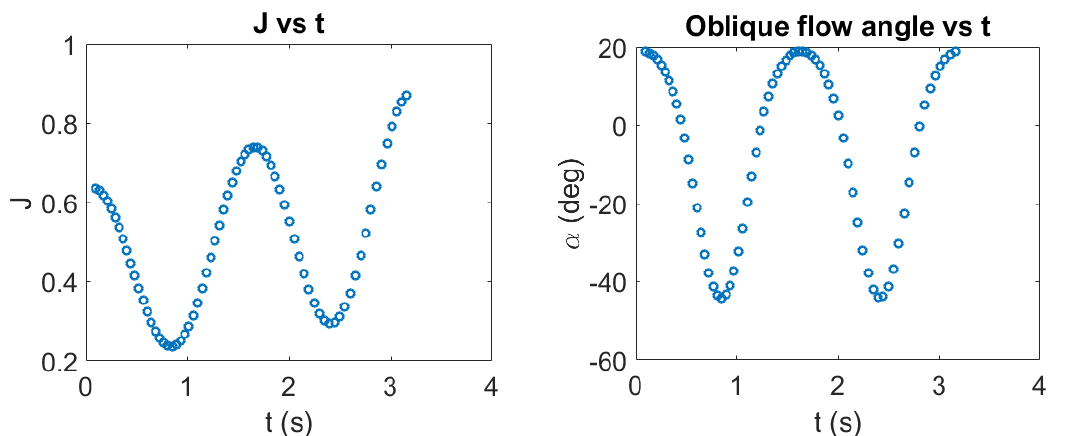
Figure 2. Discrete samples of J ( left ) and α ( right ) as a function of time for the unsteady open water propeller training case.